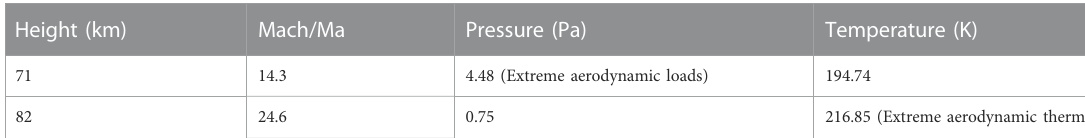
TABLE 5 Calculation working conditions of gas – thermal – solid coupling.